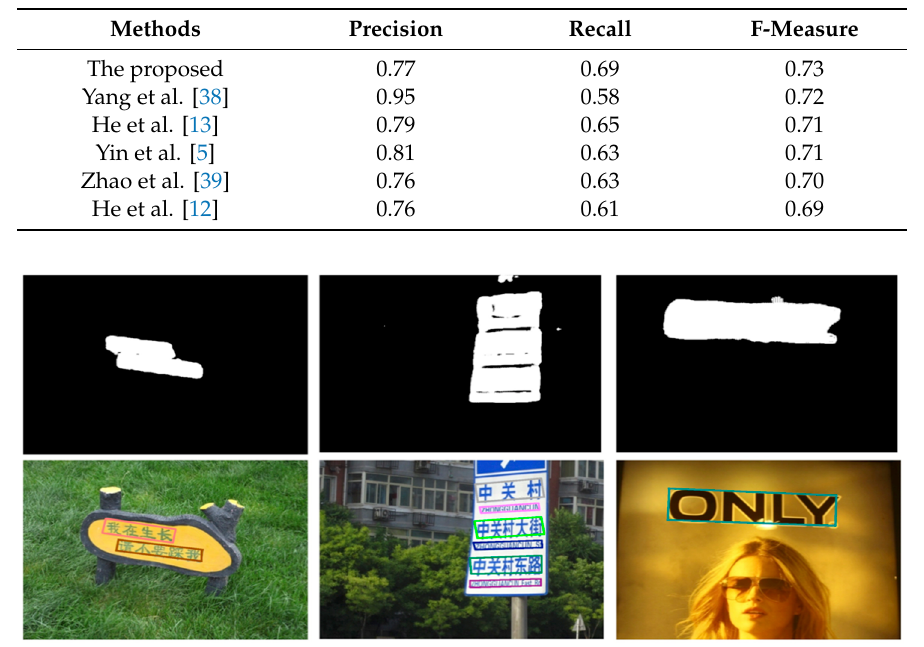
Figure 7. The performance of our approach on MSRA-TD500 dataset.